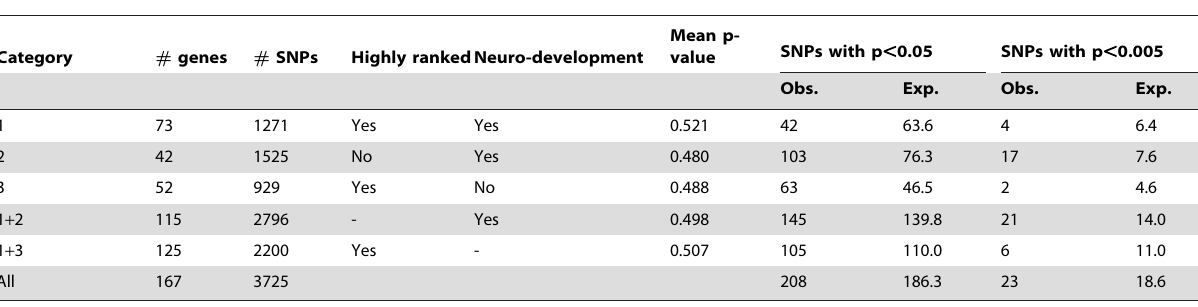
Table 2. Summary of genes and number of SNPs per test category.